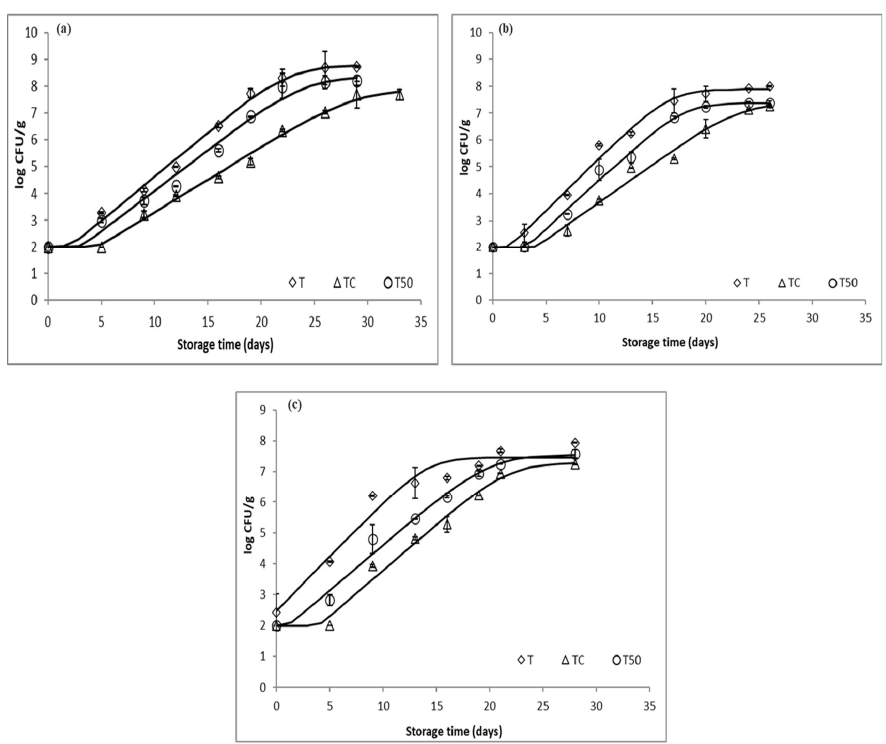
Figure 2. Growth of Pseudomonas spp. in gilthead sea bream samples slaughtered in ( a ) September 2020, ( b ) January 2021, and ( c ) April 2021 during storage at 0 °C ( ◇ T, △ TC, ○ T50) ( p < 0.05). The results were in agreement with the reported data in the literature, with similar initial H 2 S-producing bacteria and Pseudomonas bacteria counts (2.4–2.5 log CFU g −1 for both) [10,37,38]. Zhao et al. (2022) observed that H 2 S-producing and Pseudomonas spp. counts in ice slurry were lower (significant differences, p < 0.05) in comparison with those in flake ice on day 3 [10]. Therefore, it was found that the growth of the aforementioned bacteria was effectively restrained by ice slurry during storage, which was found in the present study as well. Data from the experiments during the different periods showed that when the sea water temperature was higher (September), the growth rates of the microorganisms tested were lower, and the shelf life longer, than during colder periods, showing that microor- ganisms adapted more quickly to lower preservation temperatures when the samples were slaughtered during colder periods. Therefore, it was shown that the ambient water temperature might shape the dominant microflora, microbial counts, and shelf life. When ice is used, the fish surface microflora in summertime (which is mainly responsible for microbial spoilage) may receive shock, which could explain the higher growth rates in winter [21]. Based on the obtained microbiological data, the preservative effect of the slurry ice-based cooling media did not show any seasonal pattern.